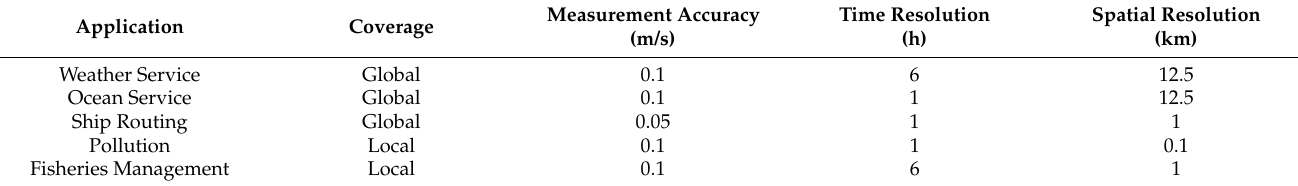
Table 1. Requirements of ocean surface current observation for different